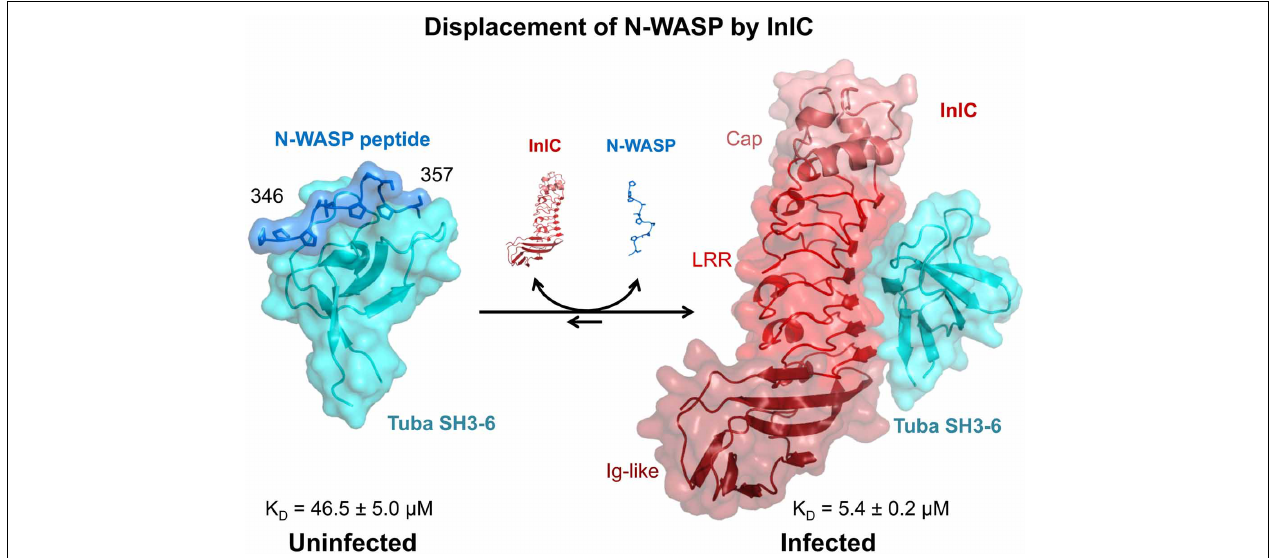
FIGURE 2 | Molecular Displacement of human N-WASP from human Tuba SH3-6 by InlC of Listeria monocytogenes : the critical physiological interaction of N-WASP with Tuba is mediated by the recognition of a proline-rich peptide of N-WASP (blue, residues 346–357) by a peptide binding groove on the sixth SH3 domain (SH3-6, cyan) of Tuba. This interaction is disrupted by InlC (shades of red: pink—N-terminal Cap domain, red—central leucine rich repeat or LRR